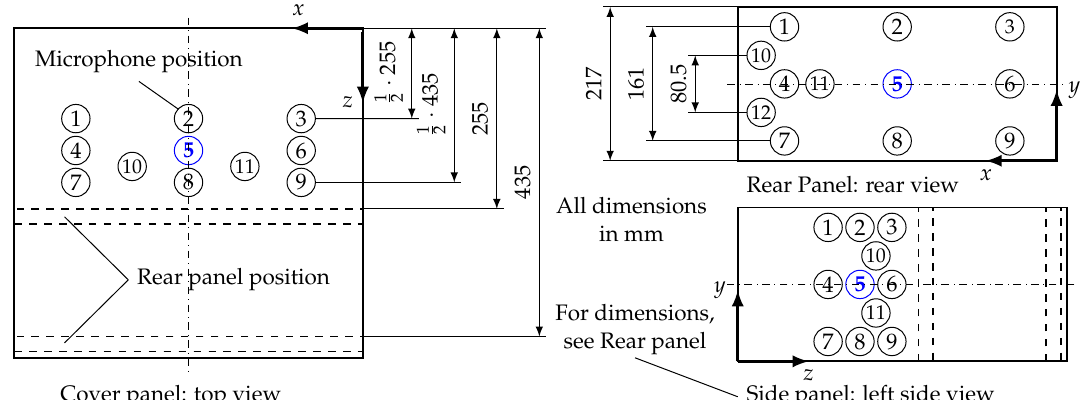
Figure 10. Sketch of the microphone positions on the cavity walls.